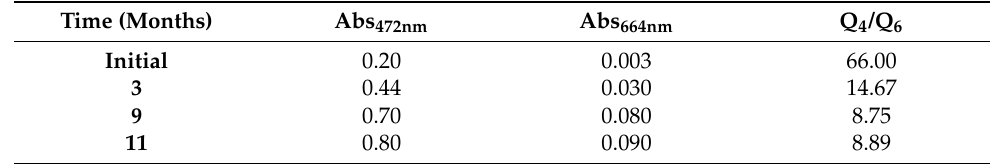
Table 3. Absorbance ratios evolution for the composting samples studied.